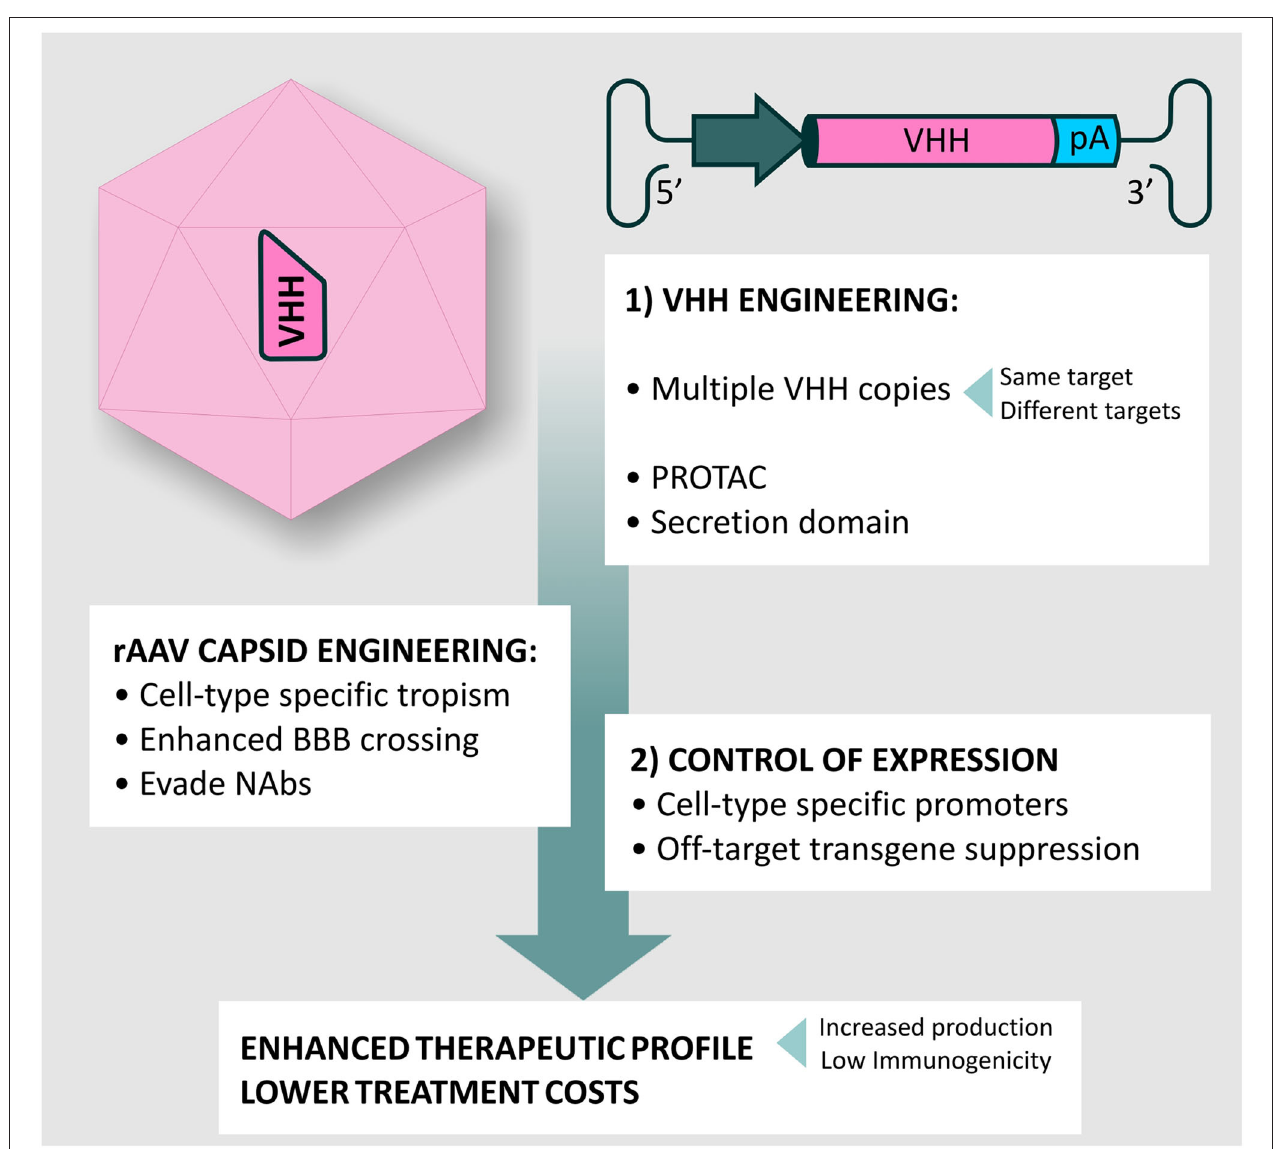
FIGURE 6 | rAAV vectors and VHH engineering for A-MAD. Summary of potential modifications for A-MAD. Engineering the rAAV capsid and transgene cassette can maximize BBB crossing, NAbs evasion and spatially restrict VHH expression to the desired cell-type. More efficient production systems will lower production costs. The outstanding versatility of VHH allows easy engineering to generate multivalent drugs, or drive proteosomal degradation of toxic protein conformations via construction of Proteolysis targeting chimeras (PROTACs). Additionally, incorporation of secretion signals into the VHH will allow targeting of extracellular aggregates, preventing prion-type transmission. Together, the impact of improved rAAV vector technology and VHH engineering will produce more efficient A-MAD-based therapeutics, with concomitant reductions in undesired side-effects and lower treatment